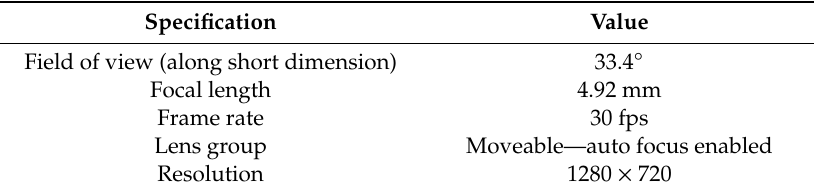
Table 1. Smartphone LG X-power digital camera